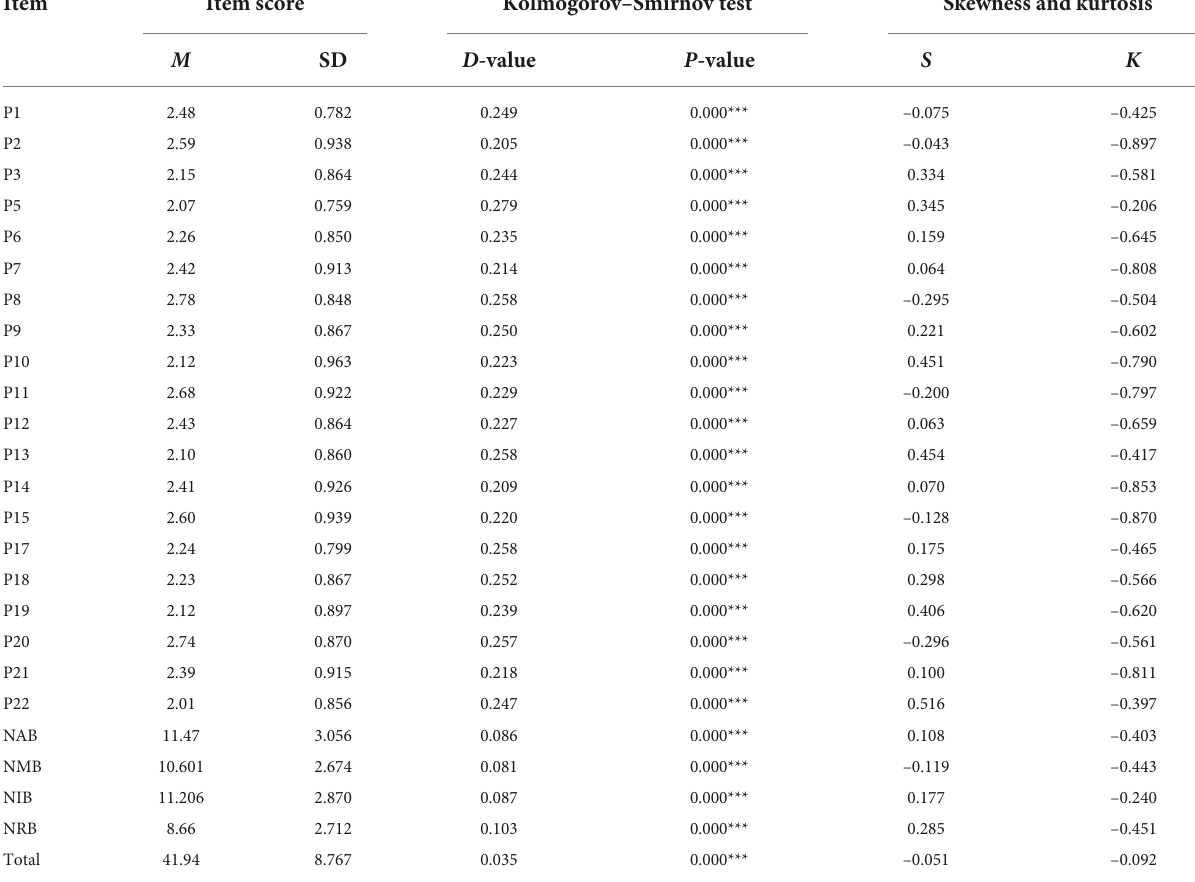
TABLE 2 Descriptive statistics and the normality of